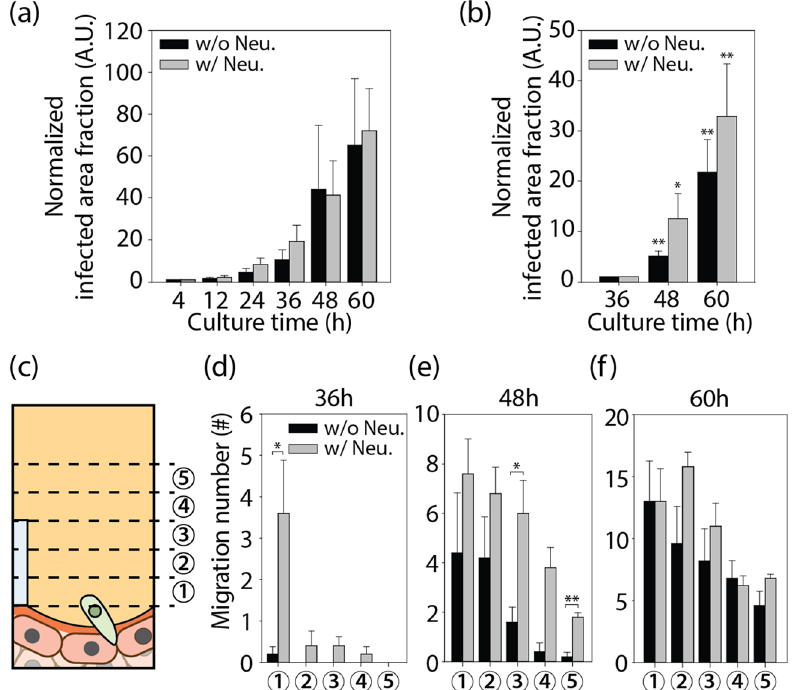
Figure 5. Tachyzoite area change ( a ) on EC monolayer and ( b ) into the ECM when cultured with or without neurons. ( c ) Quantification of the tachyzoite invasion of the ECM. (d-f) Number of individual tachyzoites in each region of interest at 50 μm intervals after 36, 48, and 60 h of tachyzoite infection (n = 5 for each group). Data are presented as averaged ± SD. Statistical significance was analyzed for panels ( b ) and ( d–f ) by one-way ANOVA with Holm-Sidak method and is indicated by asterisks as follows: *P < 0.05, **P < 0.01, ***P < 0.001.